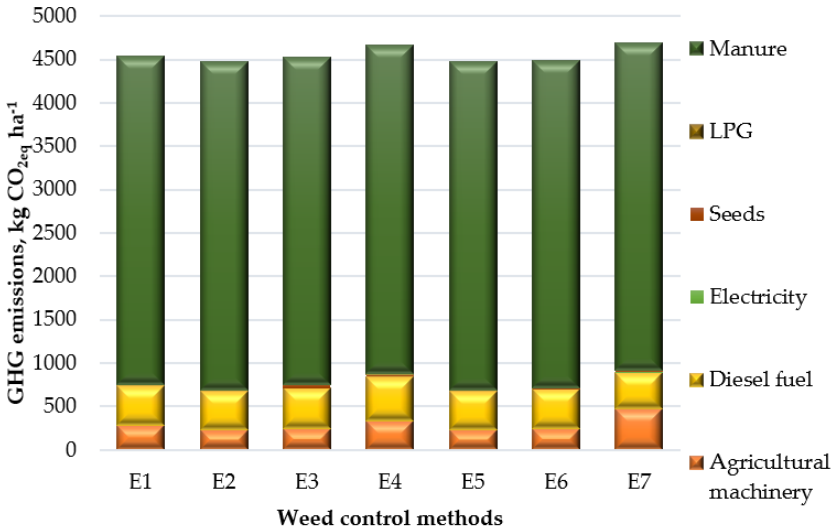
Figure 6. The impact of weed control methods on GHG emissions into the environment. The best GHG emissions ratios, showing the sustainability of organic sugar beet pro- duction technologies, were achieved when applying mechanical inter-row loosening with a diesel-powered robot (E6), an electric robot (E7), and automated inter-row loosening (E5), 5.80, 5.56, and 5.49, respectively (Figure 7).